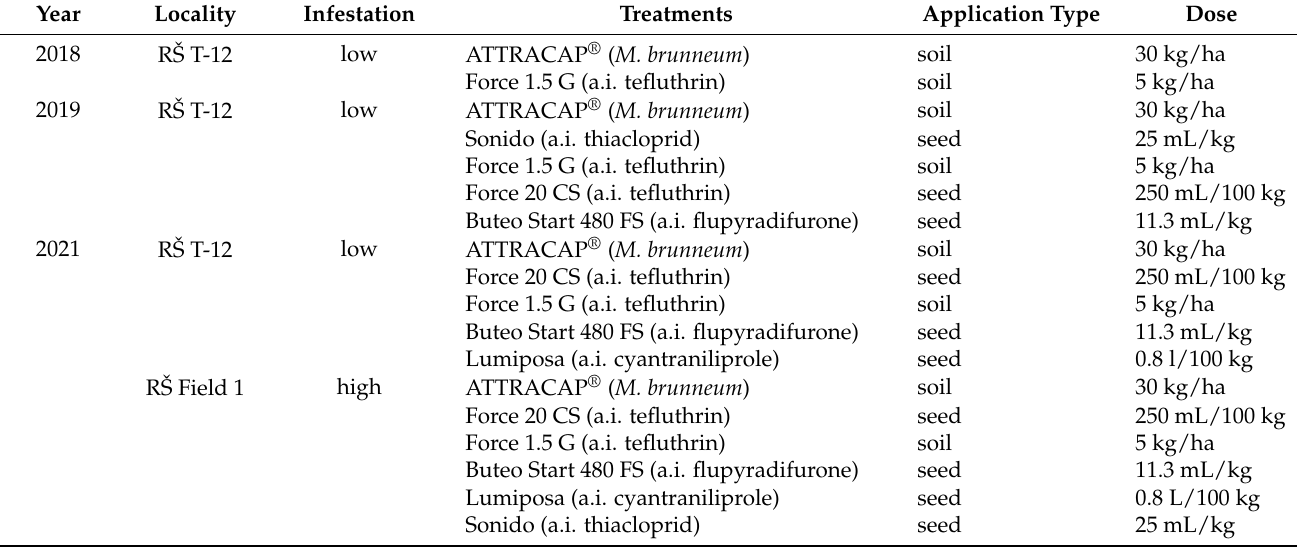
Table 1. Experimental sites, years and